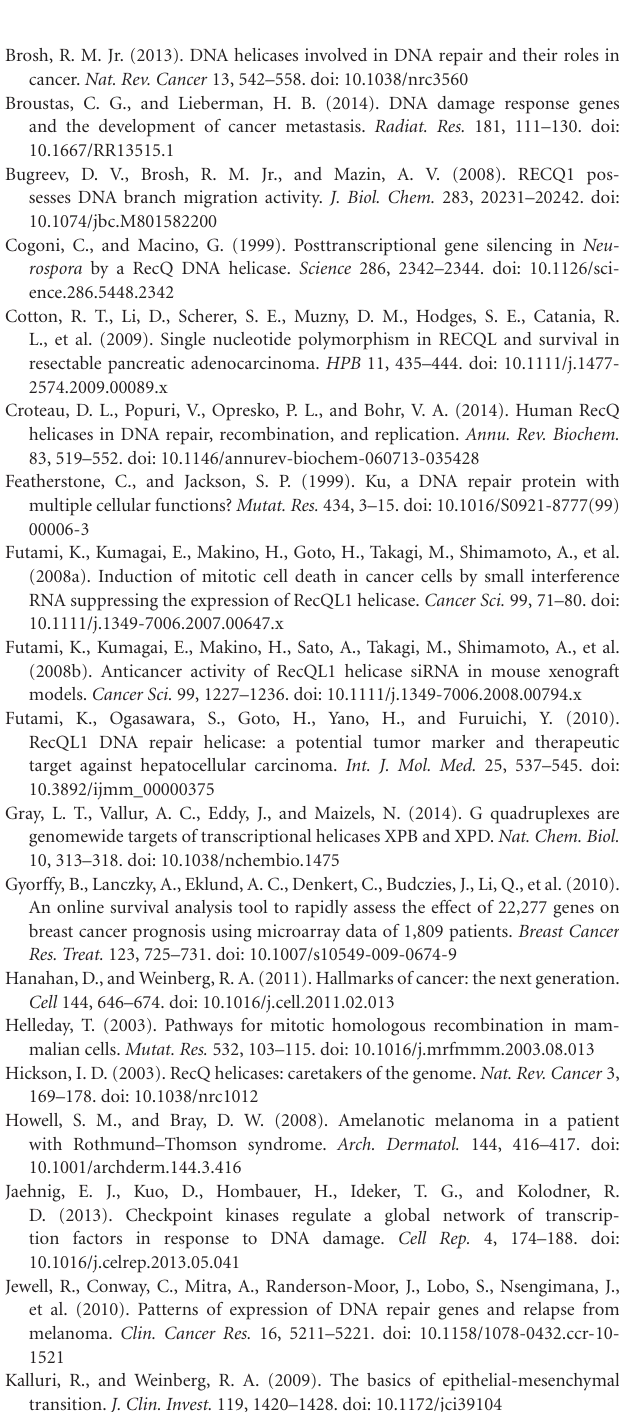
CDH1 (E-cadherin) across the NCI-60 cell lines. Mean-centered transcript z -cores are plotted on the x -axis; bars to the right show increased expression, bars to the left show decreased expression relative to the expression mean. The cell lines on the y -axis are grouped by tissue of origin. BR, breast; CNS, central nervous system; CO, colon; LE, leukemia; ME, melanoma; LC, lung cancer; OV, ovarian; PR, prostrate; RE, renal. Data was generated querying RECQL (RECQ1) as input in Cellminer